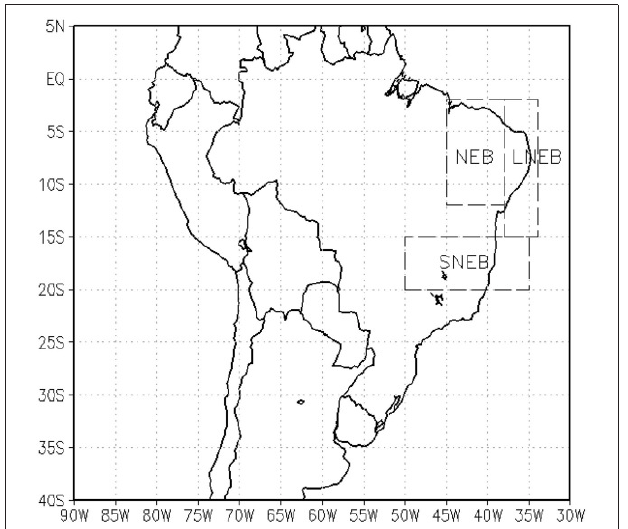
FIGURE 1 | Areas of the Northeast of Brazil used in this study: Semiarid region in Northeastern Brazil (NEB), Easternern NNB (LNEB), Southern NNB (SNEB).